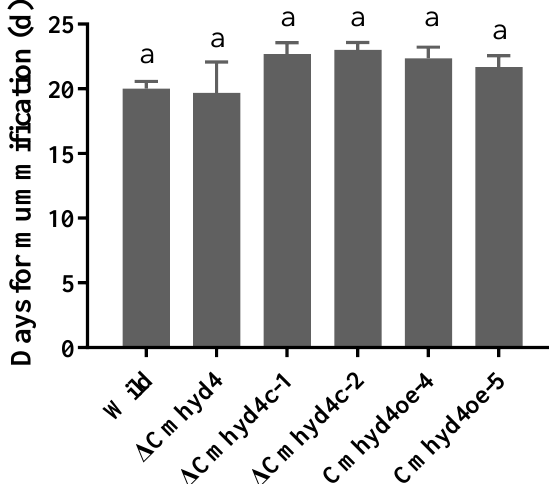
Figure 6. Conidial infecting ability of WT and mutant strains. Error bars represent the SD of three biological replicates with three technical replicates. The same “a” above the bars indicates that there is no significant difference ( p <